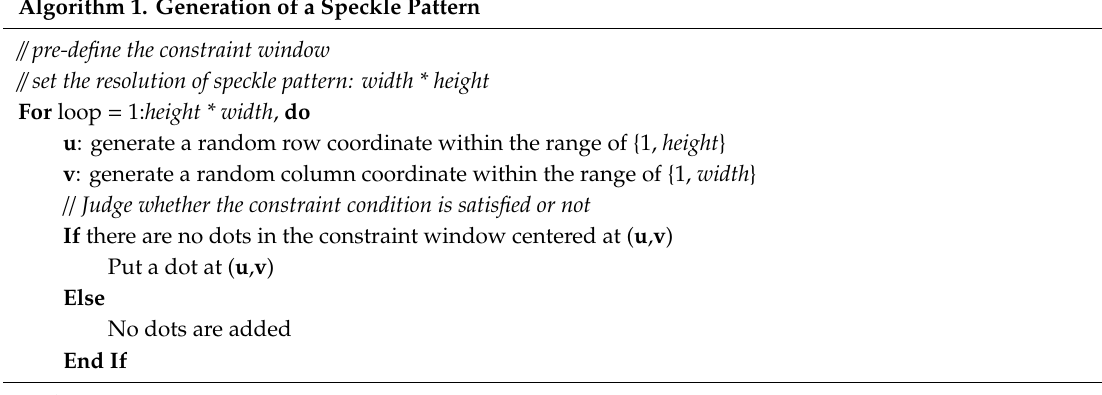
Algorithm 1. Generation of a Speckle Pattern